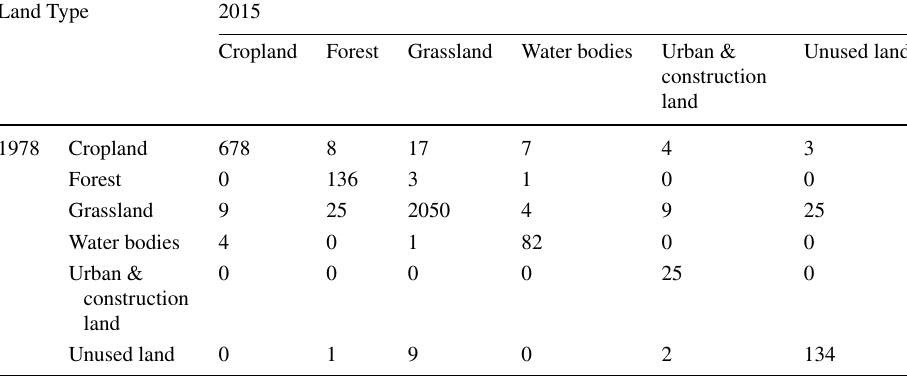
Table 9 Land use transition matrix from 1978 to 2015 in Huangfuchuan River basin (km 2